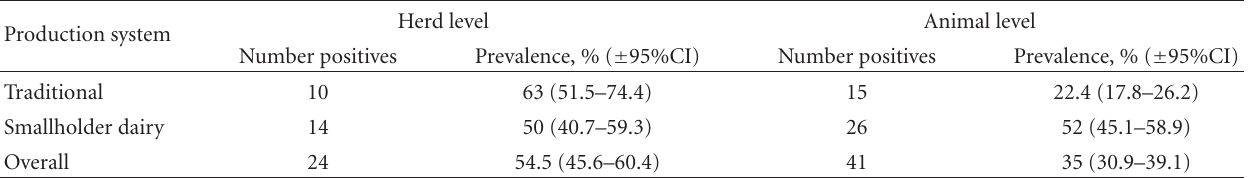
Table 2: Cryptosporidiosis prevalence (with exact ± 95% confidence intervals) in calves up to 3 months of age by production system